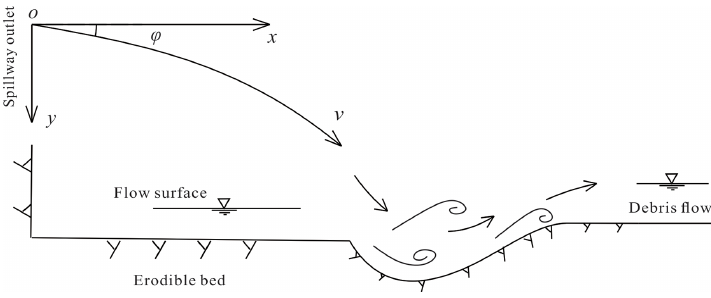
Figure 7. A diagram of dynamic parameters of debris